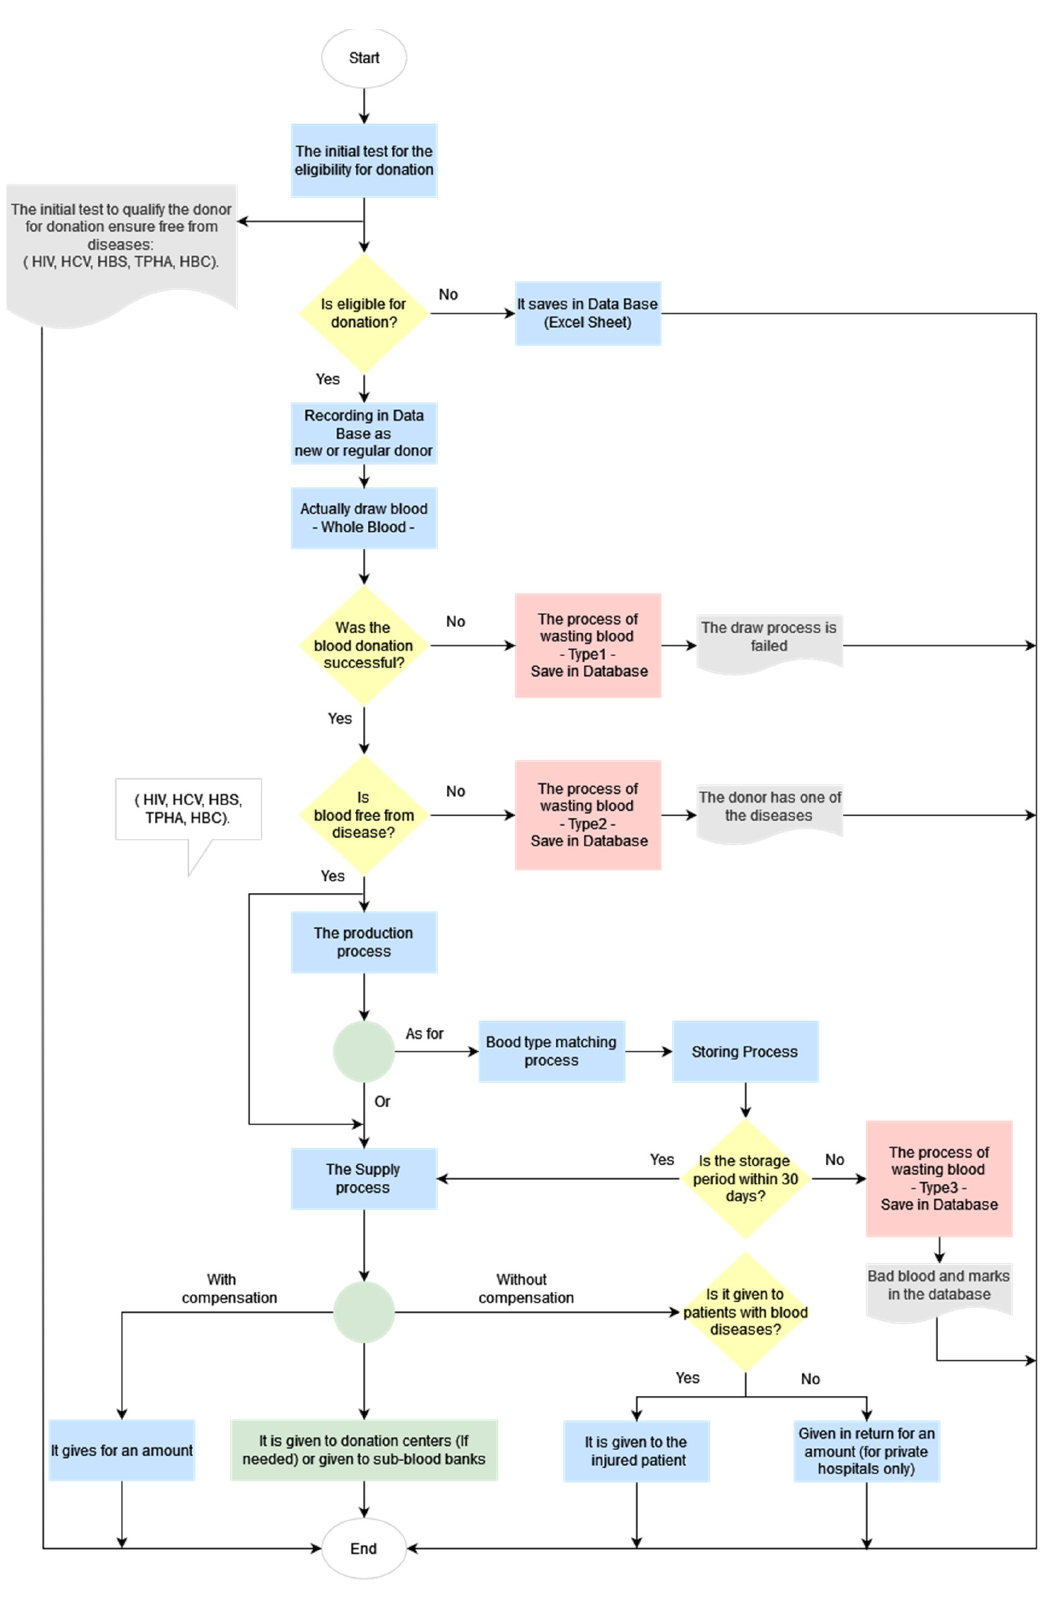
Figure A1. The flow of the paperwork-based existing system.